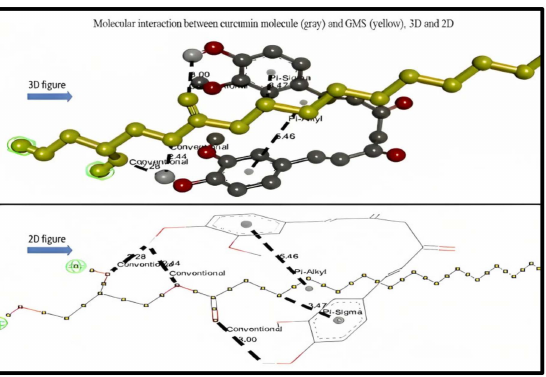
Figure 4. 3D and 2D molecular interaction between curcumin molecule (gray) and GMS